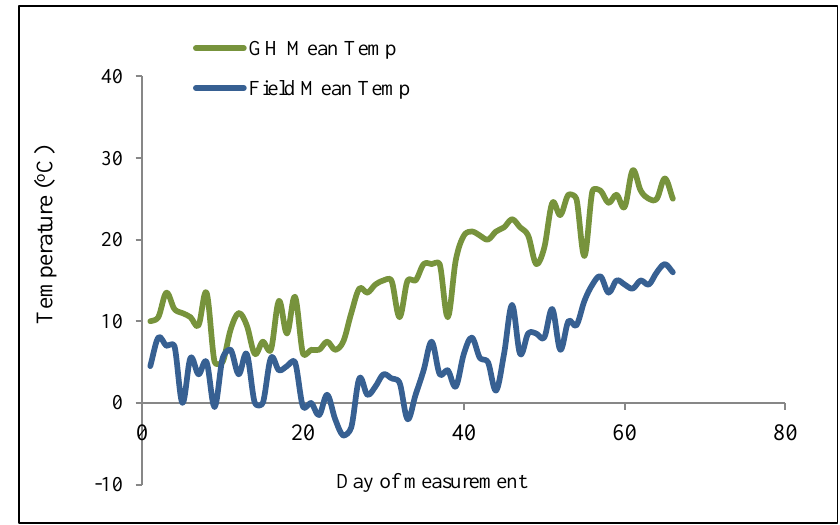
Figure 3. Mean temperature in the greenhouse and field with respect to day of measurement. GH: Greenhouse.